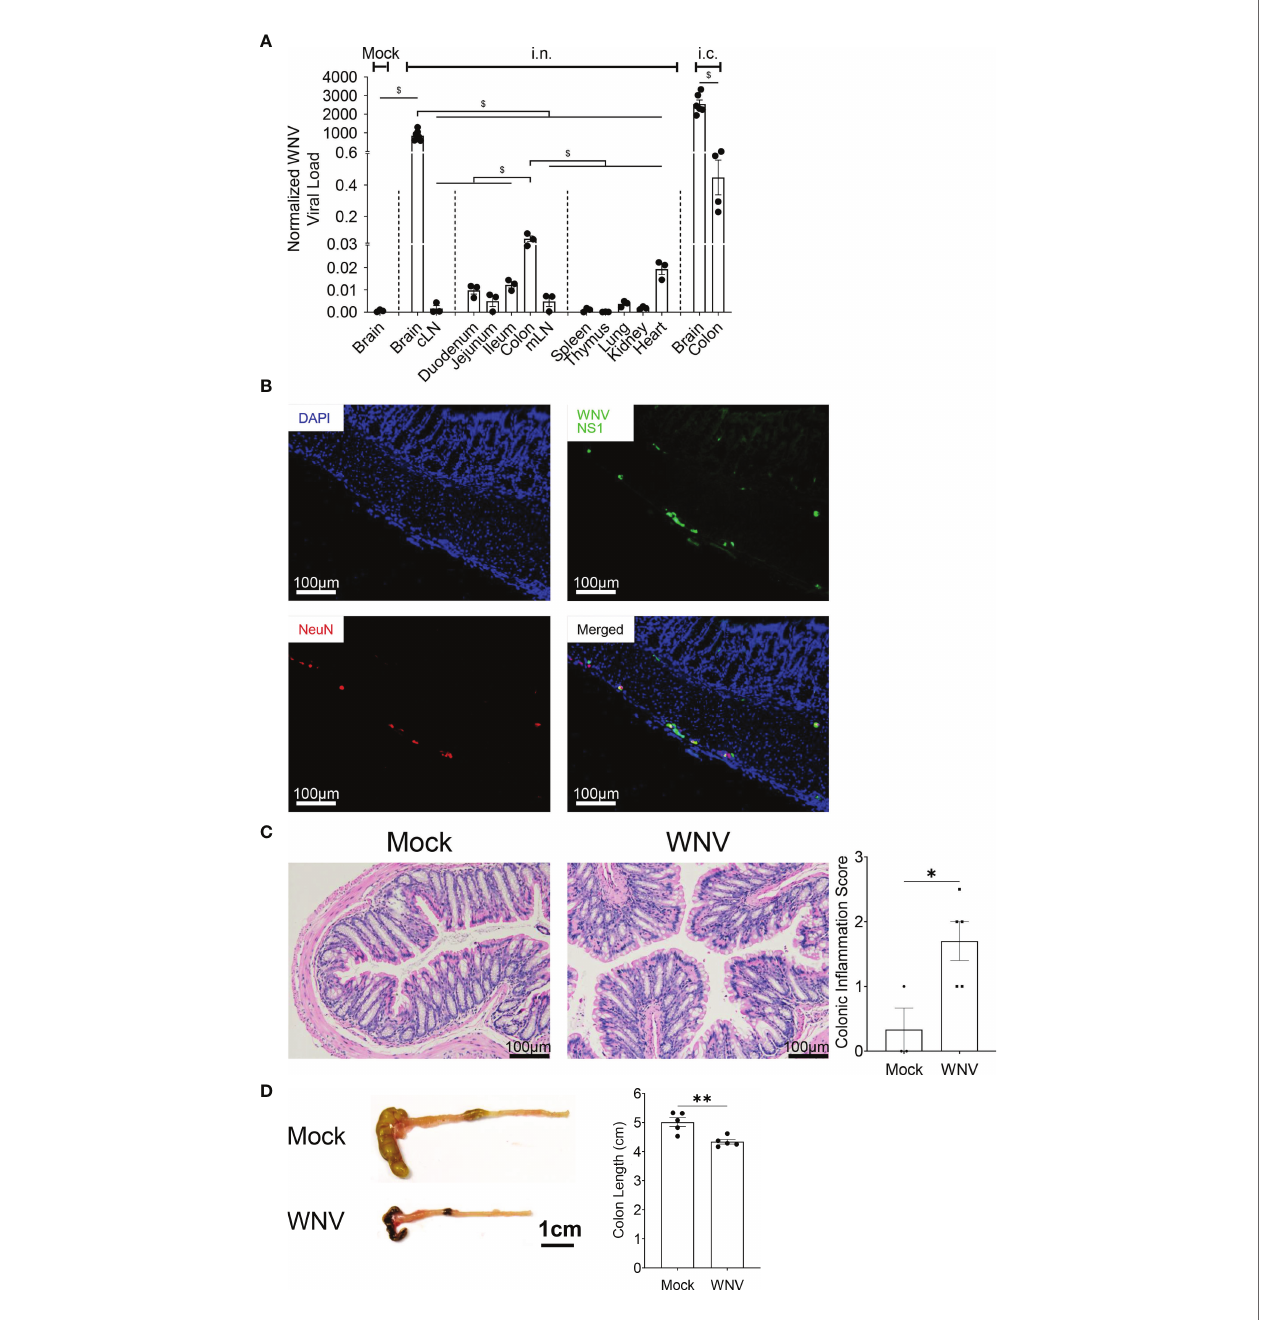
FIGURE 2 | Spreading of WNV in the colon during WNV encephalitis triggers colonic in fl ammation. Mice were fed on normal chow diet and were intranasally (i.n.) or intracranially (i.c.) infected with LD 100 WNV. (A) WNV viral load quanti fi ed for mock-infected animals (Mock) or infected animal at 7dpi by qPCR in brain, cLN, duodenum, jejunum, ileum, colon, mLN, spleen, thymus, lung, kidney, heart, n = 3-7 per organ), as well as brain and colon from mice inoculated intracranially with LD 100 WNV, as a control. (B) Representative immuno fl uorescence staining of WNV non-structural protein 1 (WNV NS1, green), and FOX-3 neuronal nuclei (NeuN, red) in colon, counterstained with DAPI (blue) from 7 dpi LD 100 WNV-infected mice fed on a normal diet. Scale bar represents 100 m m. (C) H&E-stained colonic tissue sections from mock-infected (Mock) or 7 dpi LD 100 WNV-infected (WNV) mice fed on a normal diet evaluated for colonic in fl ammation. Representative histological images are shown for each group in the left panel, and quanti fi cation of colonic in fl ammation scoring are shown in the right panel (n = 3-5 per group). Scale bar represents 100 m m. (D) Colon length of mock-infected (Mock) or 7 dpi LD 100 WNV-infected (WNV) mice fed on normal diet were assessed (n = 5 per group). Scale bar represents 1cm. Data are represented as mean ± SEM with ∗ p < 0.05; ∗∗ p < 0.01; $ p < 0.001 by t test or two-way